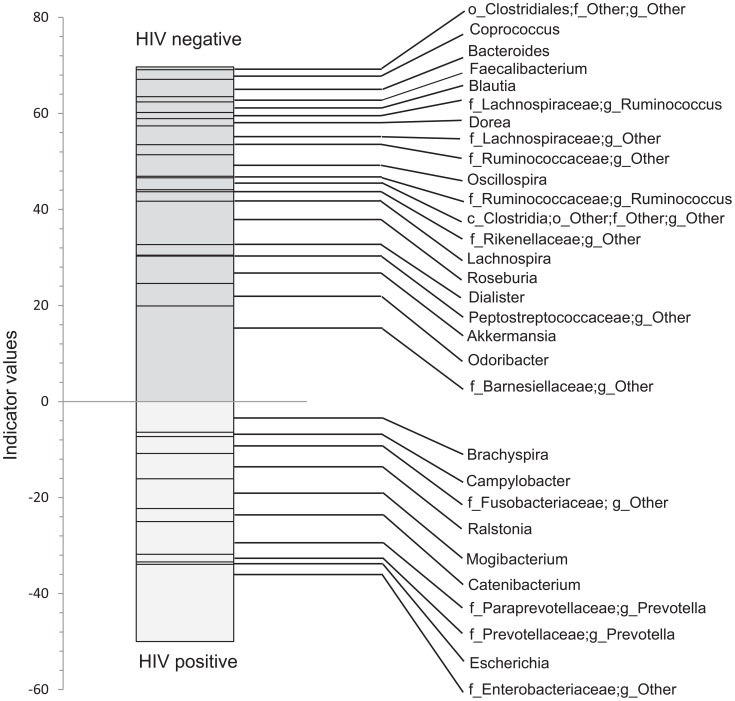
Indicator values for bacterial taxa, which are indicative of control or HIV samples.Indicator species analysis was performed after rarification and log transformation. Analysis was blocked by site. Genera and those unclassified bacterial members of families that not able to be classified down to a particular genus, that also have indicator values >15 and p<0.05 are shown.